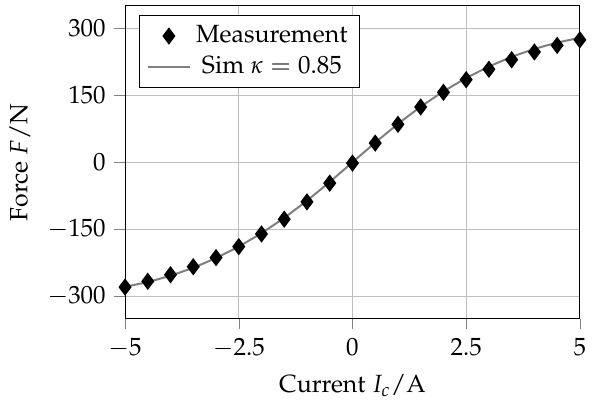
Figure 11. Resulting static magneto-static force obtained by simulation with an effective thickness of the bearing to compensate for leakage and fringing effects (comparison to measured